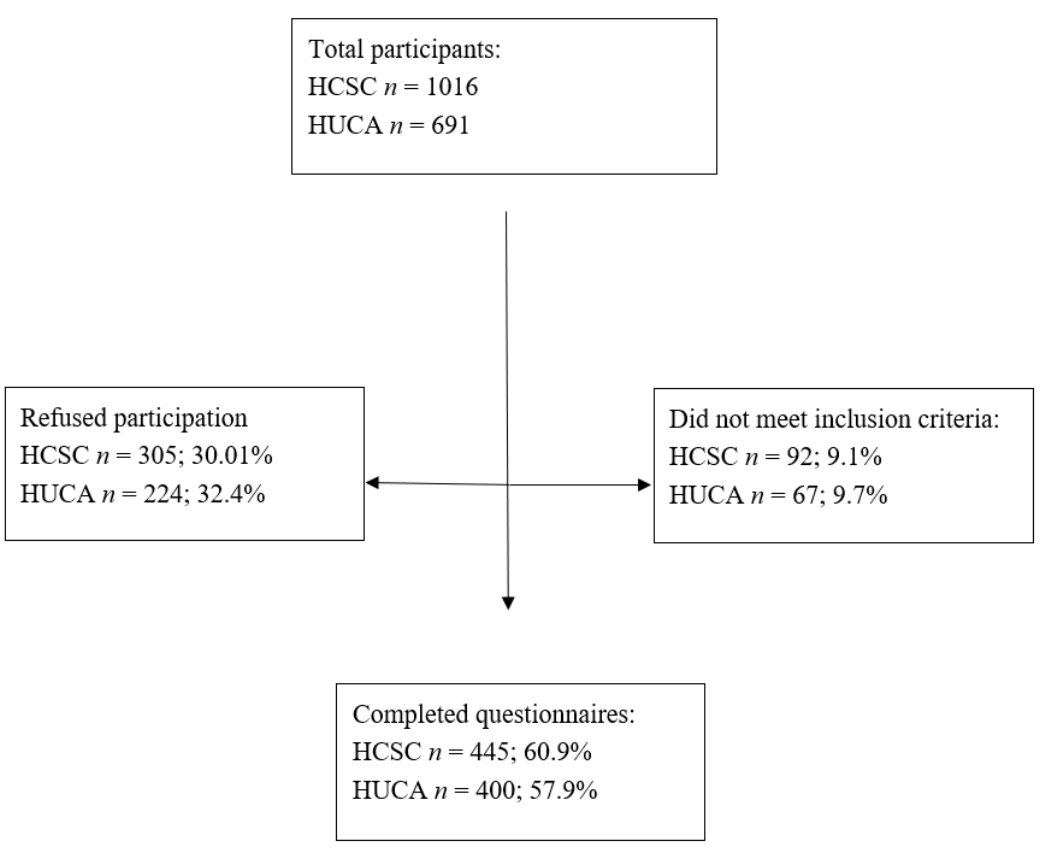
Figure 1. Participants. Note: HCSC = Hospital Clínico San Carlos, HUCA = Hospital Universitario Central de Asturias.